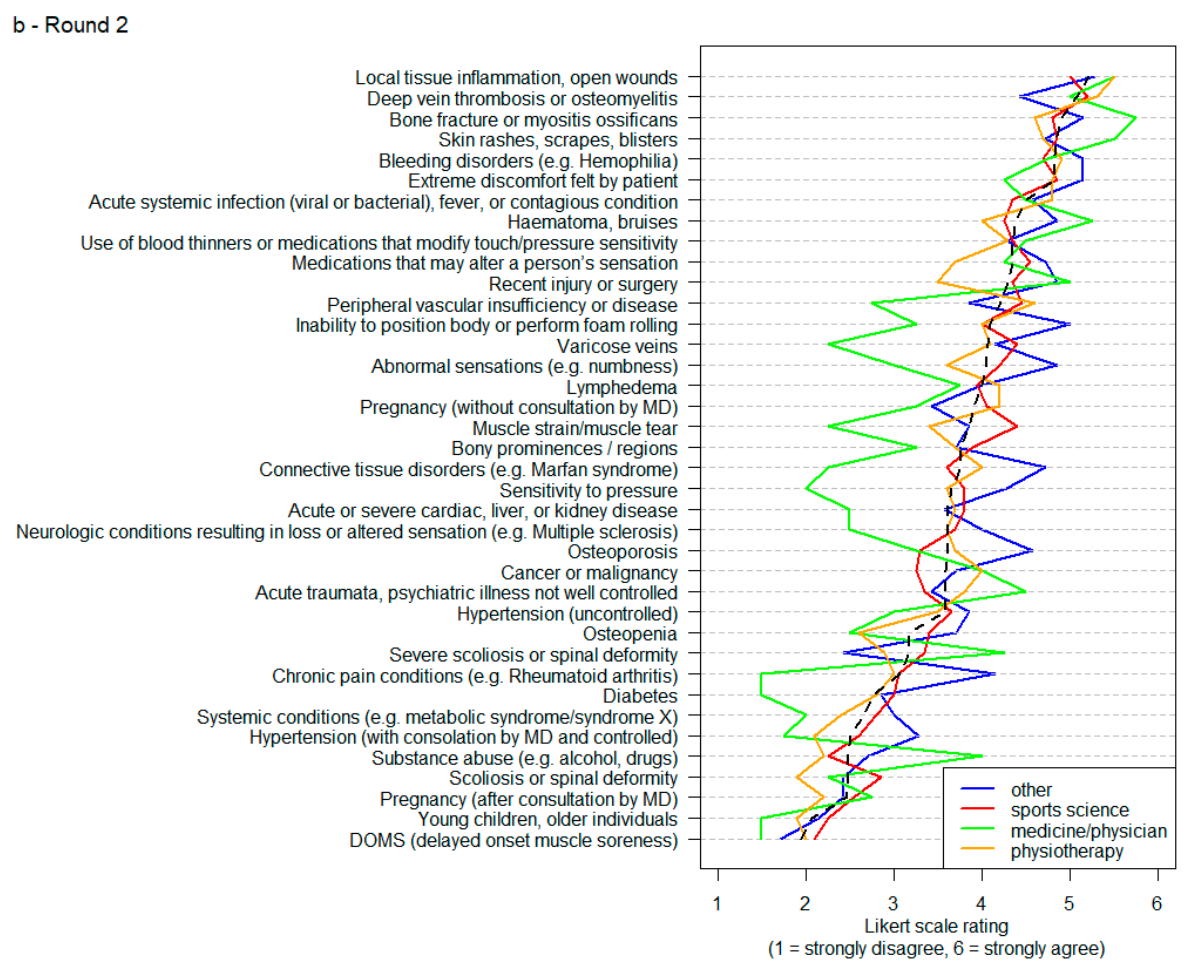
Figure 8. Participants’ responses in Delphi according to professional background in round 1 ( a ) and round 2 ( b ). Note: The black line indicates the mean.